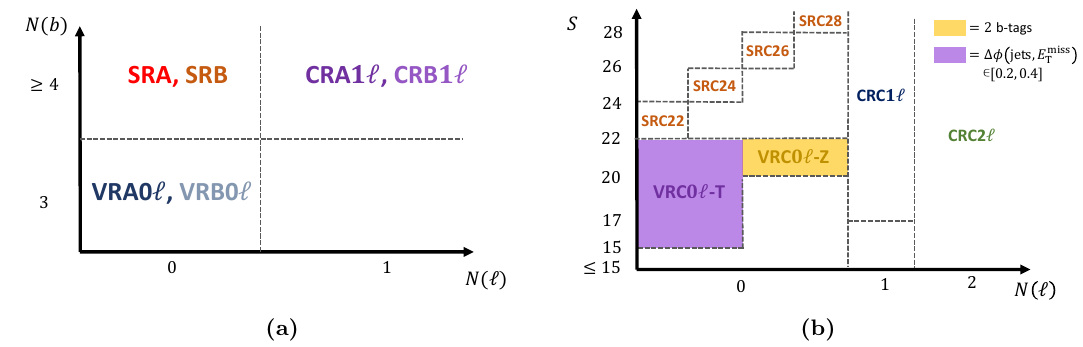
Figure 3. Schematic diagrams of the (cid:12)t strategies for (a) the A-, B- and (b) C-type regions. Generally the CRs require a di(cid:11)erent lepton multiplicity than the SRs. The validation regions are de(cid:12)ned with a lower b -jet multiplicity requirement, except in the case of the VRC0 ‘ -T region, which instead inverts the SR min (cid:1) (cid:30) (jet ; p miss ) 1 (cid:0) 4 T